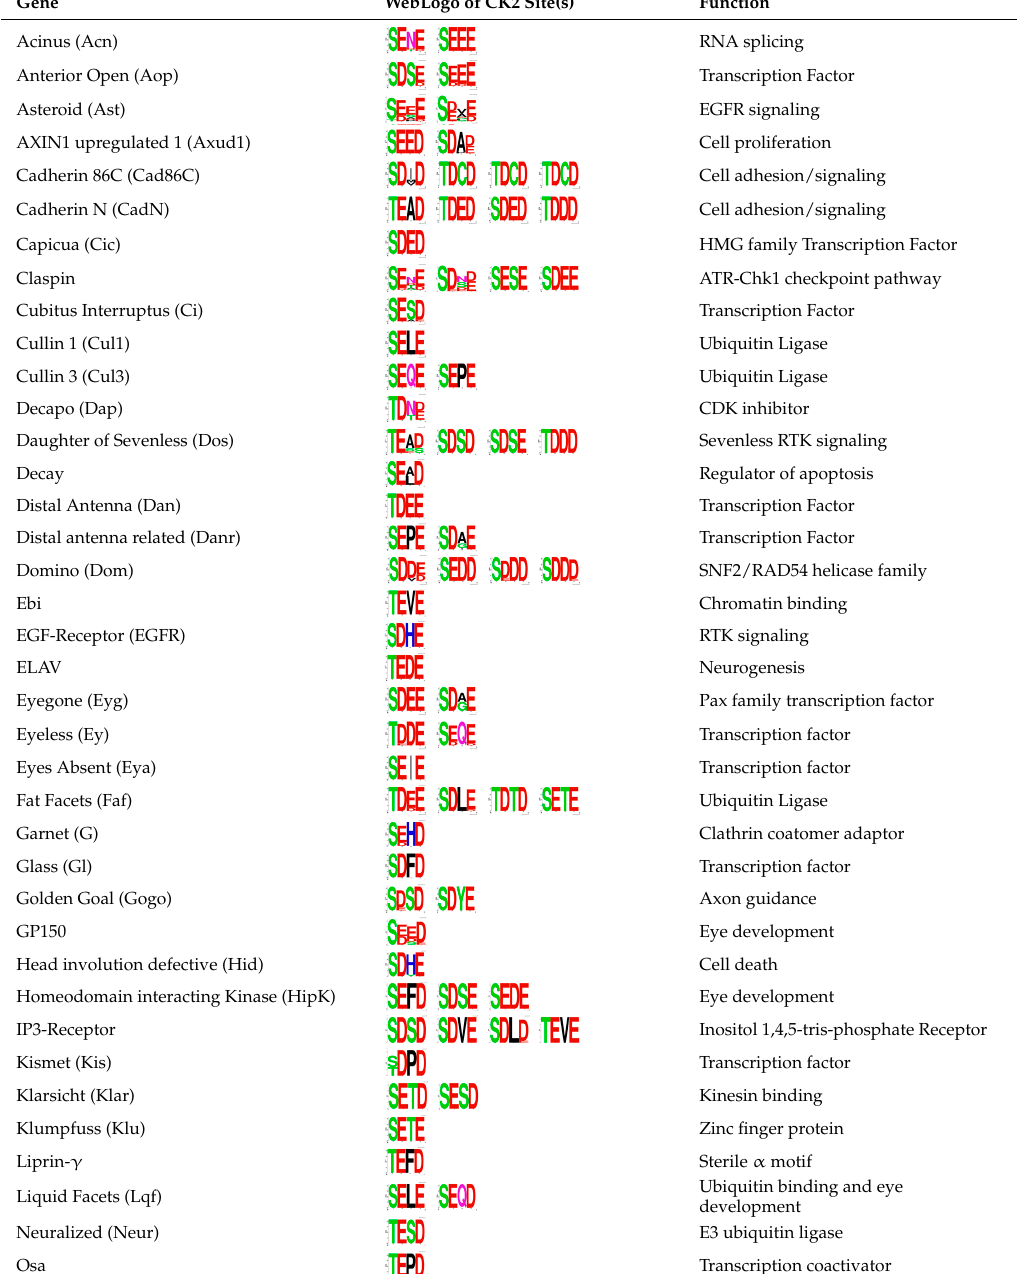
Table 5. Genes expressed in the developing eye with conserved CK2 sites.